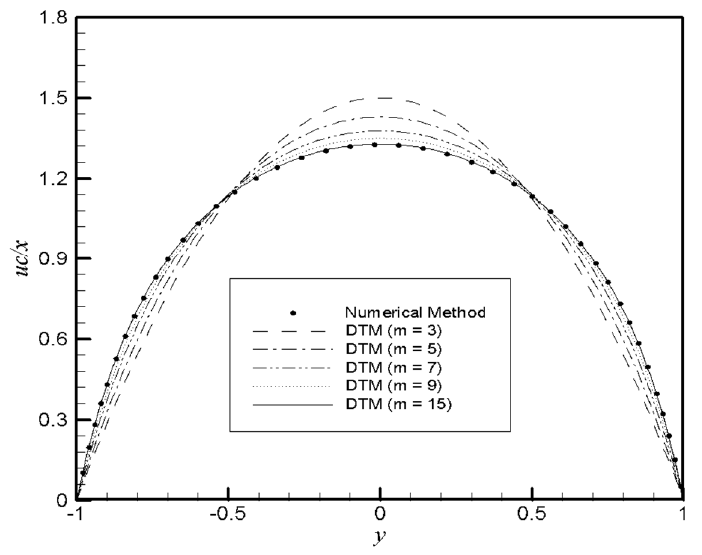
Figure 2. The analytical results for uc / x obtained by the DTM at different orders of approximation compared with the numerical results Re = 5 and α = − 1.